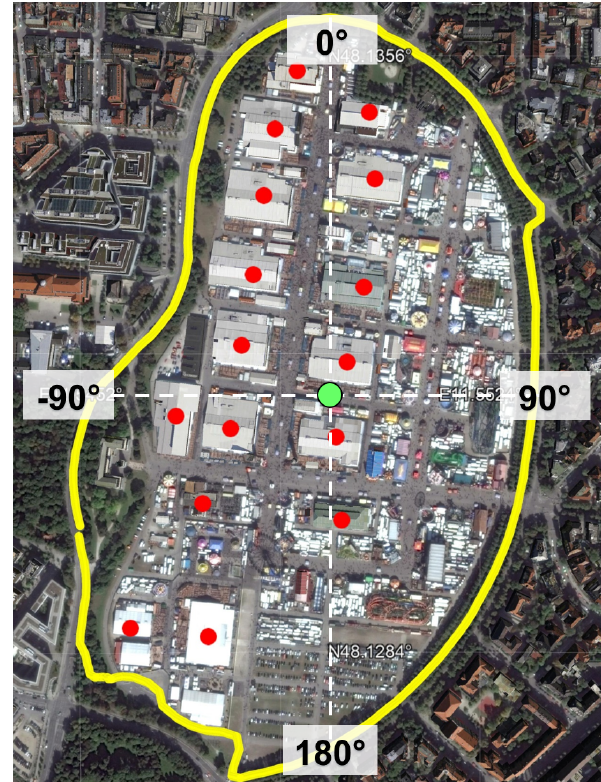
Figure 2. Standard route around Oktoberfest (yellow) including the locations of the 16 tents (red) and the center point (green). Map data are from © Google, DigitalGlobe.